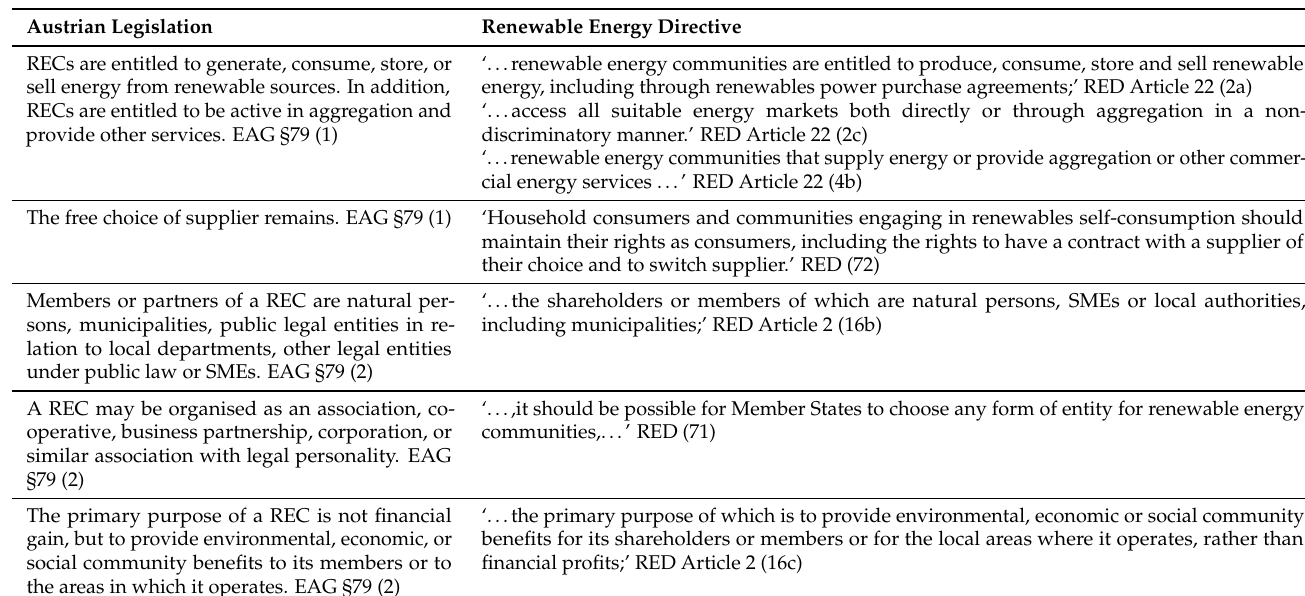
Table 1. Austrian legislation on Renewable Energy Communities (RECs) compared with the European guidelines of the Renewable Energy Directive [5]